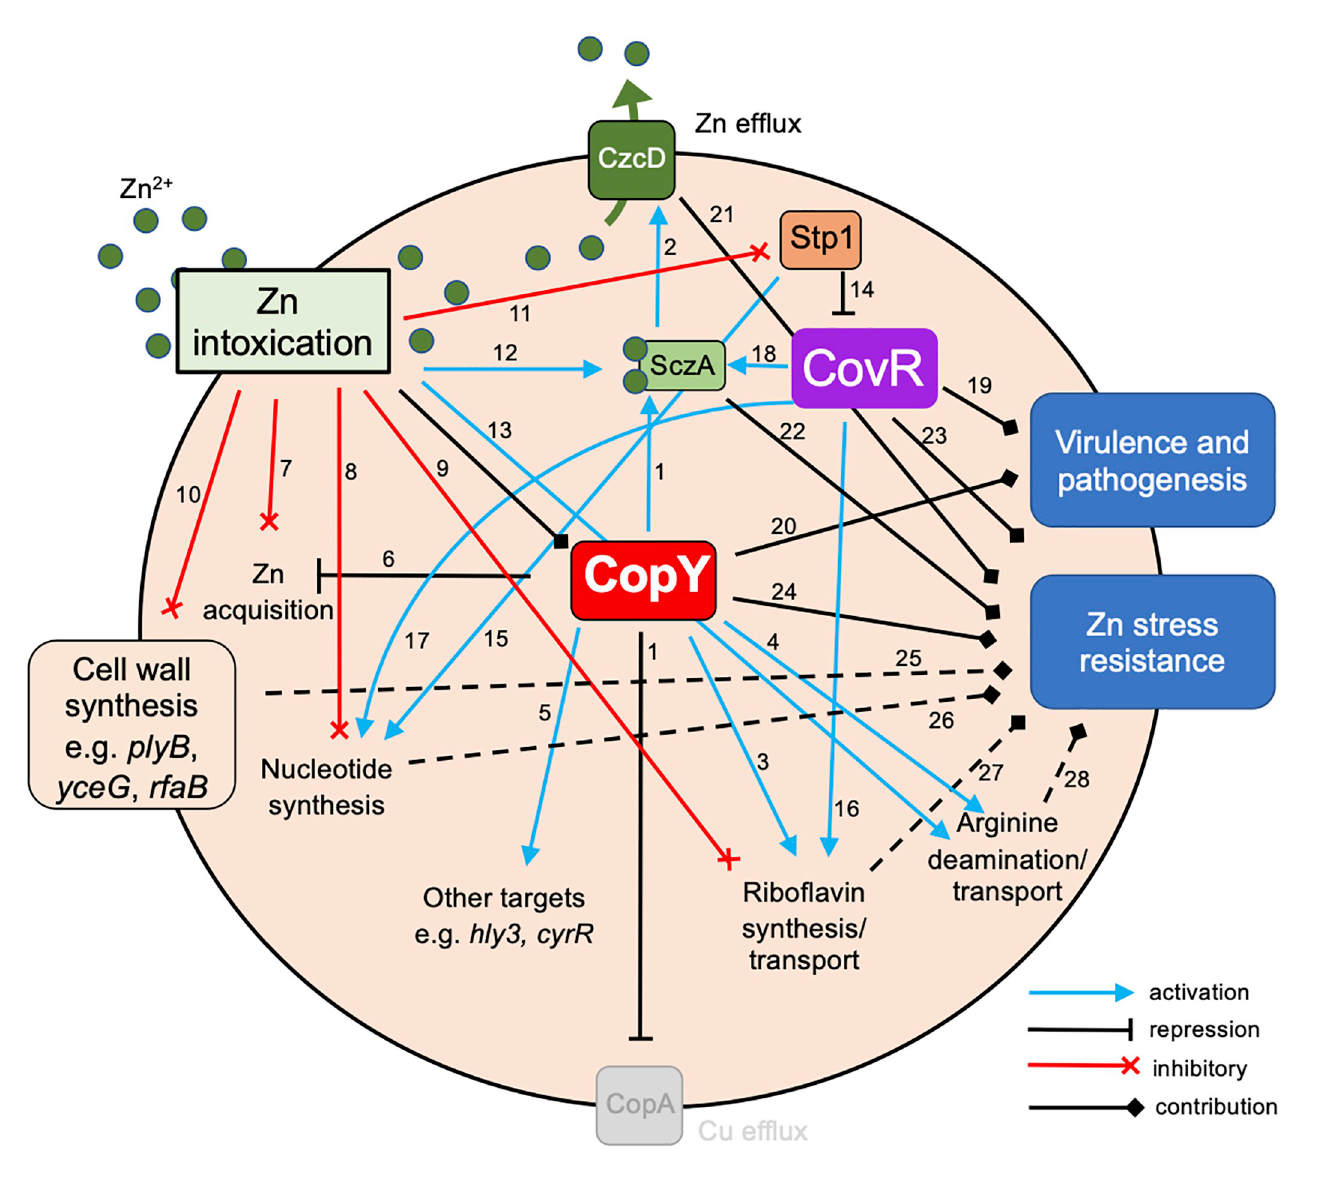
Fig 12. A genetic network in GBS for resisting Zn intoxication. CopY represses copA but also activates sczA expression 1 ; which in turn controls czcD for Zn efflux 2 ; CopY also activates riboflavin synthesis and/or transport 3 , arginine deamination and transport 4 , other targets 5 and represses adcA 6 . Zn intoxication is inhibitory towards Zn acquisition 7 , de novo nucleotide 8 and riboflavin synthesis 9 pathways, cell wall synthesis genes 10 and Stp1 11 ; Zn intoxication activates sczA 12 and arginine deaminase 13 . Stp1 represses activity of CovR 14 and activates de novo purine synthesis 15 . CovR has activation roles for riboflavin 16 and nucleotide synthesis genes 17 and sczA 18 ; Virulence and pathogenesis require contributions from CovR 19 and CopY 20 . Resistance to Zn stress requires functional czcD 21 , sczA 22 covR 23 , copY 24 and there are yet to be determined mechanisms of cell wall synthesis genes 25 , nucleotide 26 and riboflavin synthesis 27 and arginine deamination 28 processes that contribute to Zn resistance in GBS. Dotted lines indicate contributions that remain to be characterized. Terms activation and repression refer to gene or protein regulatory activities, inhibitory and contribution refer to pathway or process level interactions. Interactions are based on gene expression data, phenotypes of isogenic mutants, cell and animal assays or prior published literature